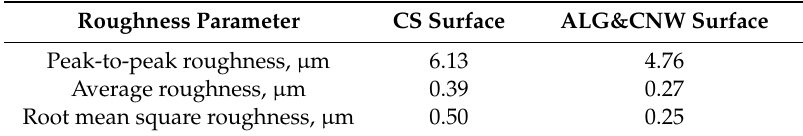
Table 1. Roughness parameters of CS and ALG&CNW surfaces of the bilayer CS–ALG&CNW sca ff old. Roughness